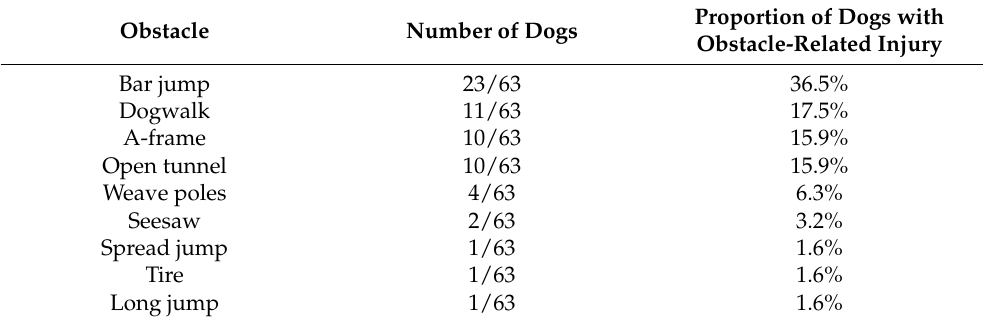
Table 3. Obstacles involved in injuries of 63 dogs. Performance of each obstacle is presented in Video